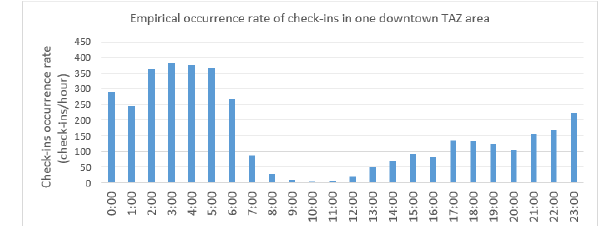
Figure 4. Empirical occurrence rates of check-ins in one downtown TAZ area